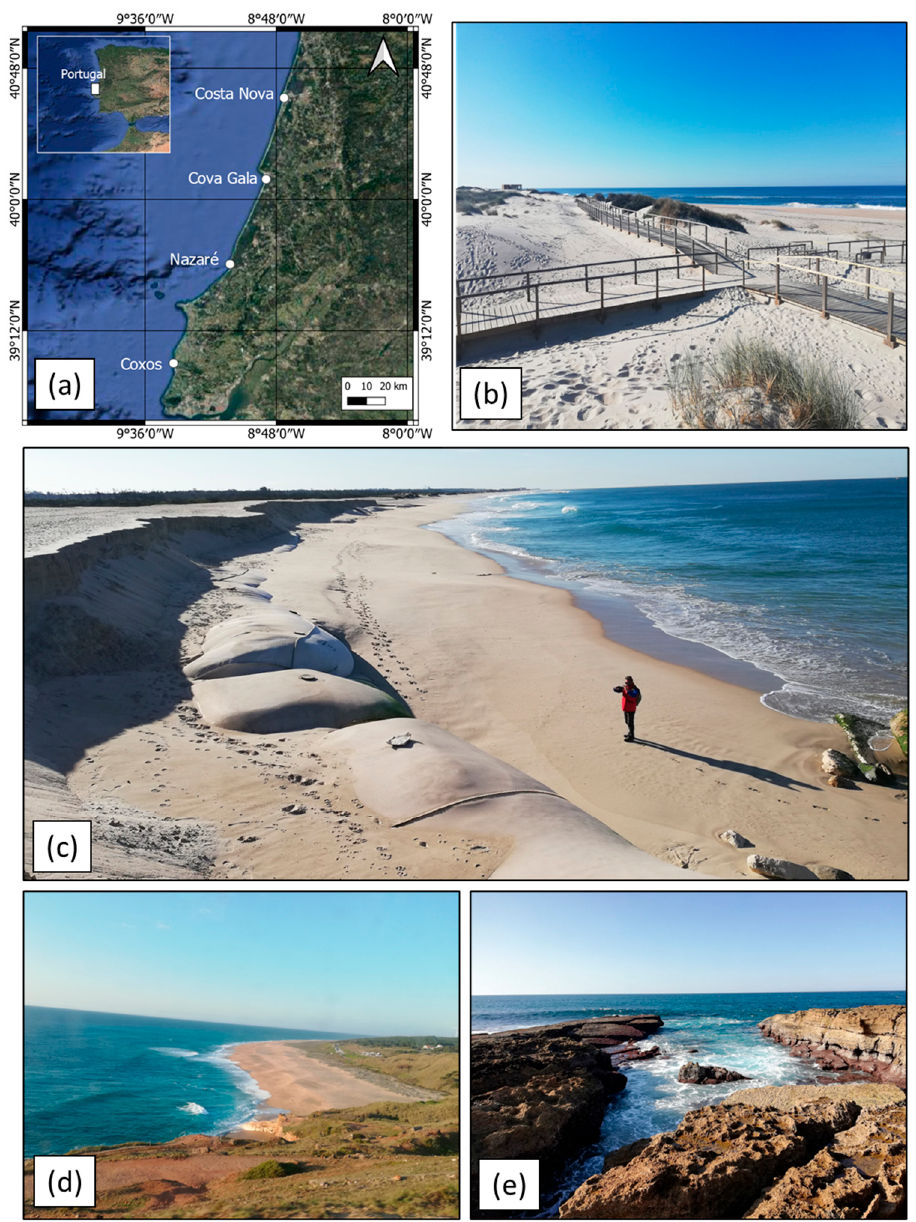
Figure 2. Coastal areas surveyed in Portugal; ( a ) locations of study areas; ( b ) sandy coast of Costa Nova; ( c ) sandy coast of Cova Gala; ( d ) sandy coast of Nazaré; ( e ) rocky coast of Coxos. As with south-eastern Sicily, the central Atlantic coast of Portugal is not an area where The Portuguese coastline extends for approximately 990 km. It is divided into different Tropical Cyclones form. Tropical Transition is the natural process responsible for the trans- geomorphological units represented by sandy beaches, dunes, sand, and rocky cliffs, com- formation of an extra tropical system into a tropical system. In addition, a recent study bined with river mouths, estuaries, lagoonal systems, and anthropogenic areas (Figure [61,63], based on a climate change scenario showing 1 °C less global warming than the SRES A1B scenario [64,65], suggests an eastward extension of the development region of tropical